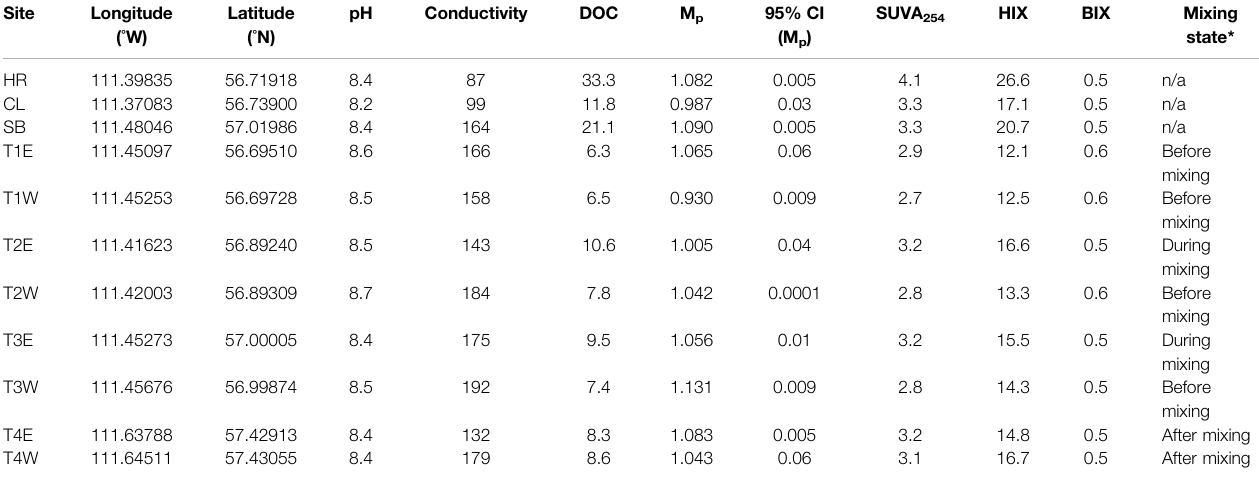
TABLE 1 | Sampling coordinates, pH, electrical conductivity, bulk DOM properties, and mixing state in the LAR. 95% CI denotes a 95% con fi dence interval. Units: Conductivity (µs cm − 1 ), DOC (mg C L − 1 ), M p (kDa), and SUVA 254 (L mg − 1 C m − 1 ).